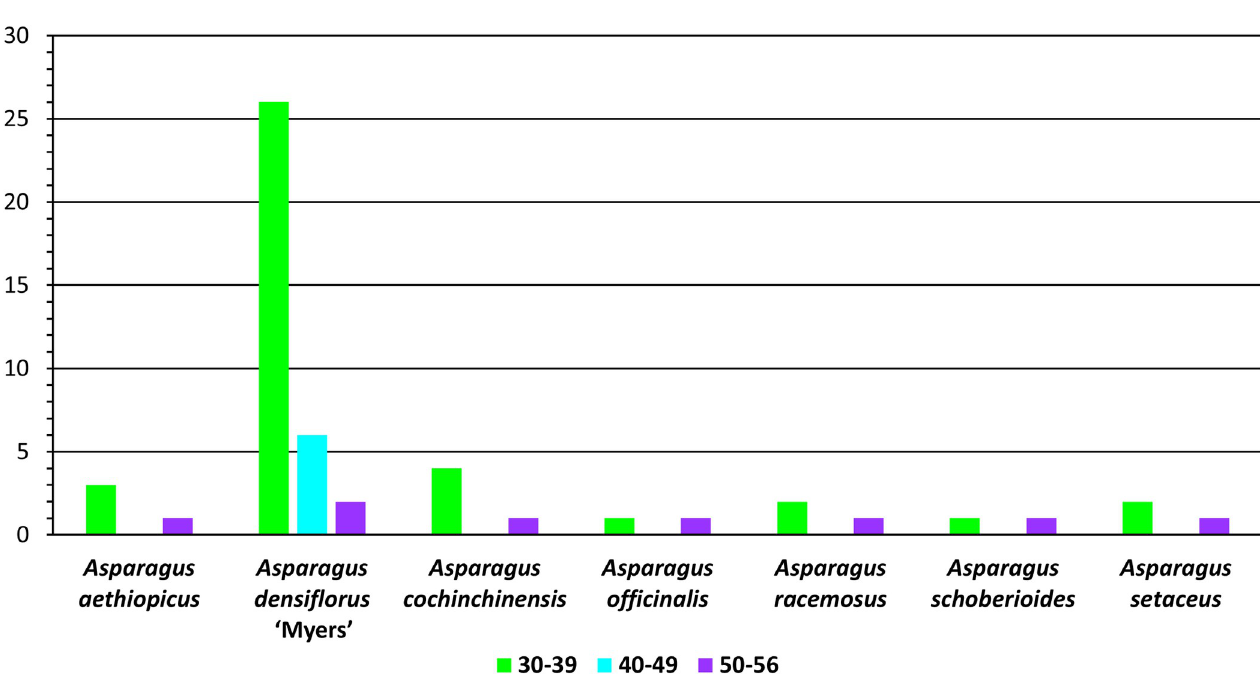
Fig 7. Frequency of long sequence repeats in specified length intervals.